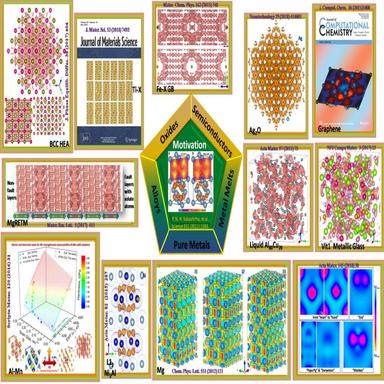
Applications of bonding charge density in pure metals (Al, Ag, Fe, Mg, Ti), alloys (Co-based and Ni-based alloys Fe-X alloys, Mg-RE-TM alloys , refractory high-entropy alloys, Ti-X alloys), metal melts (vit1 metallic glass , Al-Cu), oxides (AgO, Ag2O , and Fe3O) semiconductors (graphene, sulfur, sulfides, and SiC), and structure defects (stacking faults, anti-phase boundari